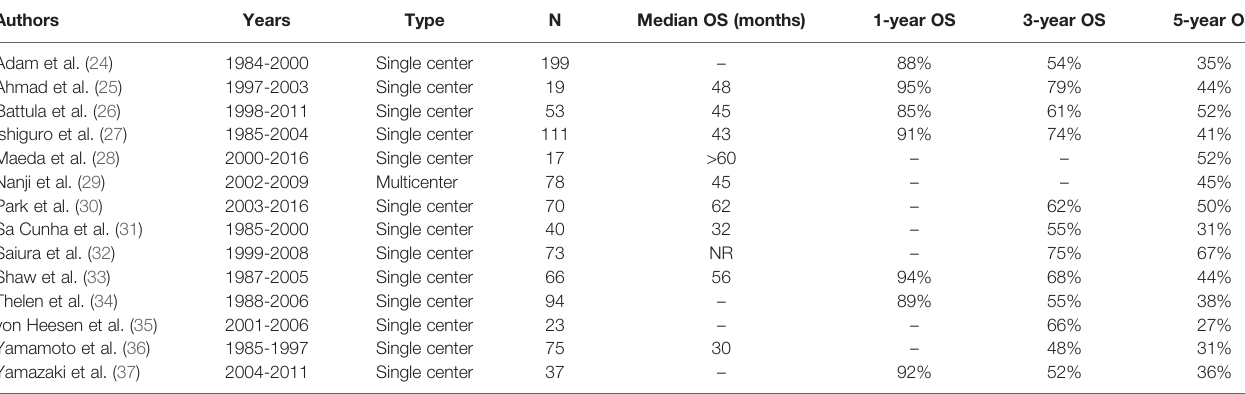
TABLE 1 | Survival after repeat resection for colorectal cancer liver metastasis recurrence in the liver.